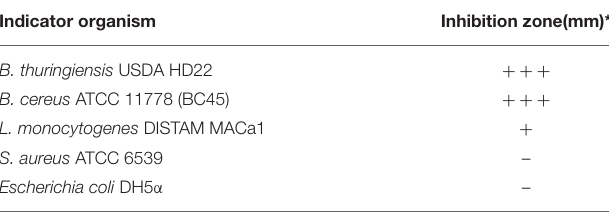
TABLE 1 | Antimicrobial spectra of the active supernatant of B.cereus RC6. Indicator organism